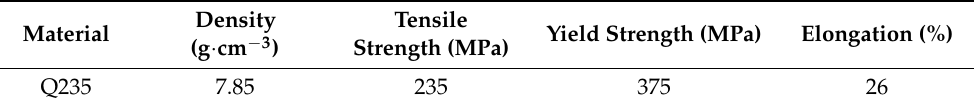
Table 4. Physical properties of steel Q235.